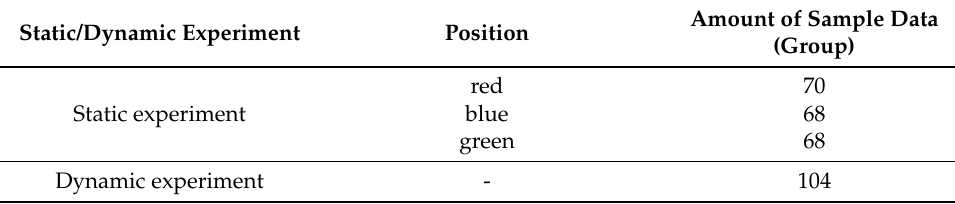
Table 3. The amount of data collected by the experiment to test our designed positioning system. The data is obtained by one tag and three anchors, each performing a ranging as a group. Amount of Sample Data Static/Dynamic Experiment Position (Group) red 70 Static experiment blue 68 green 68 Dynamic experiment -